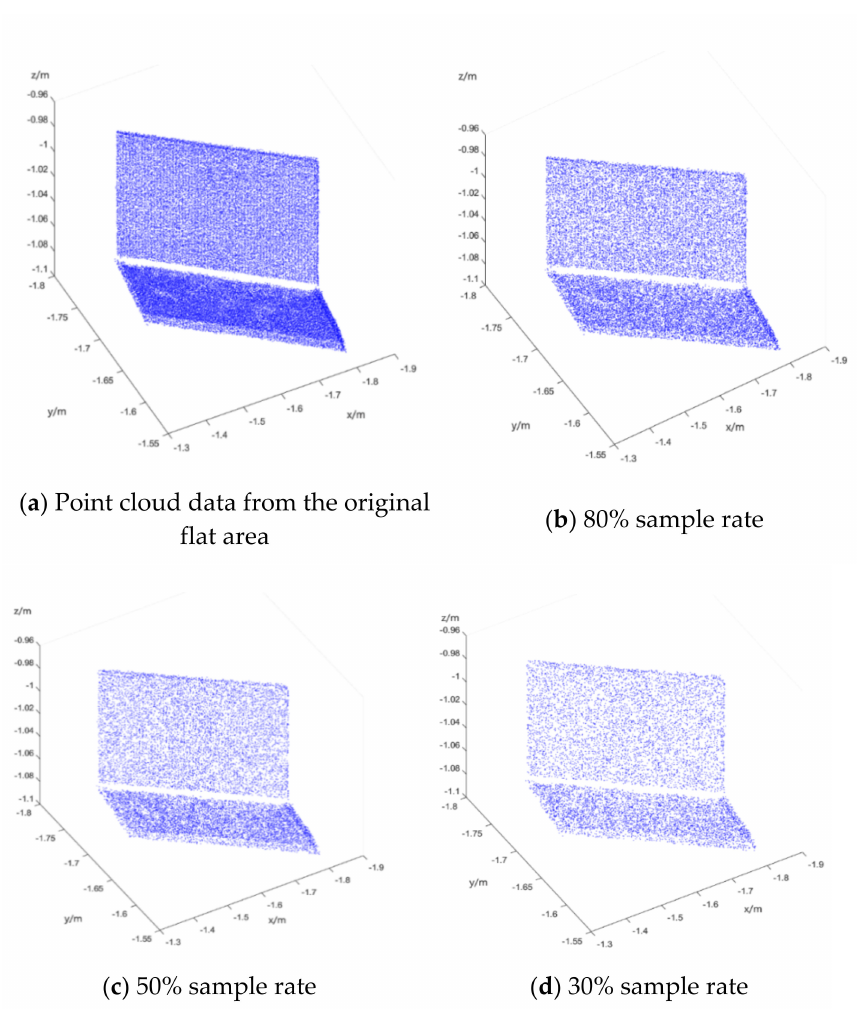
Figure 6. Simplified results with different sample